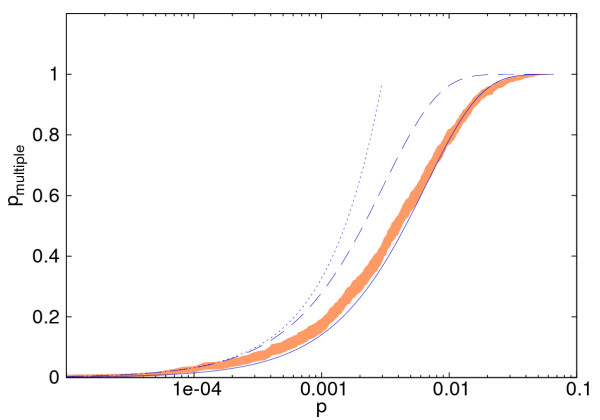
Fitting an effective number of independent categories. The multiple category p-value, pmultiple, versus p-value for the data set of van 't Veer et al. [13], using 327 large Gene Ontology categories with more than 20 genes. The yellow band shows 95% confidence interval of sample label permutation results, based on 1000 random lists, and the blue curves show the results of Equation (1), with the fitted Neff = 152 (solid line), the total number of categories N = 327 (dashed line), and also the Bonferroni correction (dotted line).